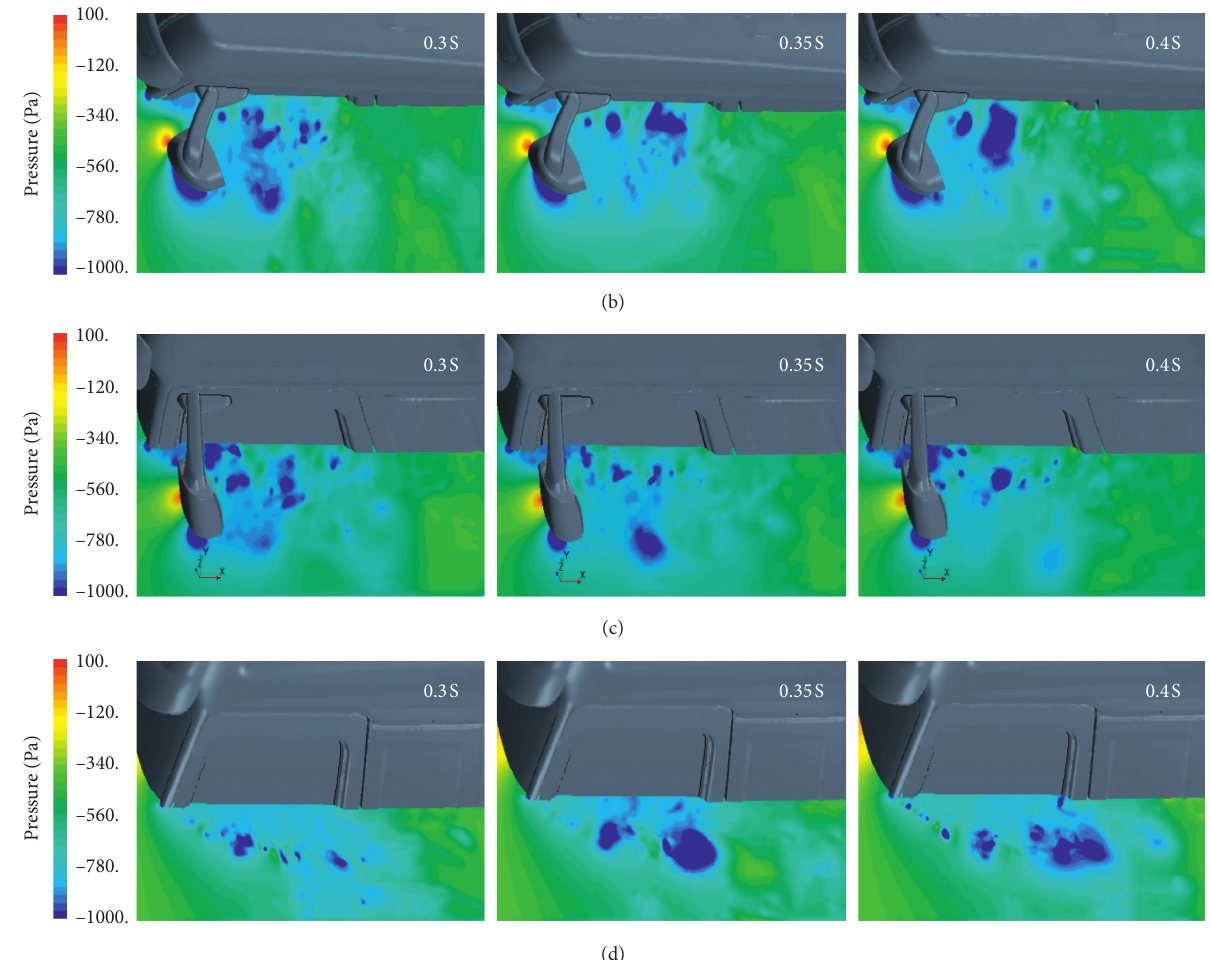
Figure 7: The transient pressure contour at different times for (a) OSRVM, (b) OSRVM B, (c) OSRVM C, and (d) NO